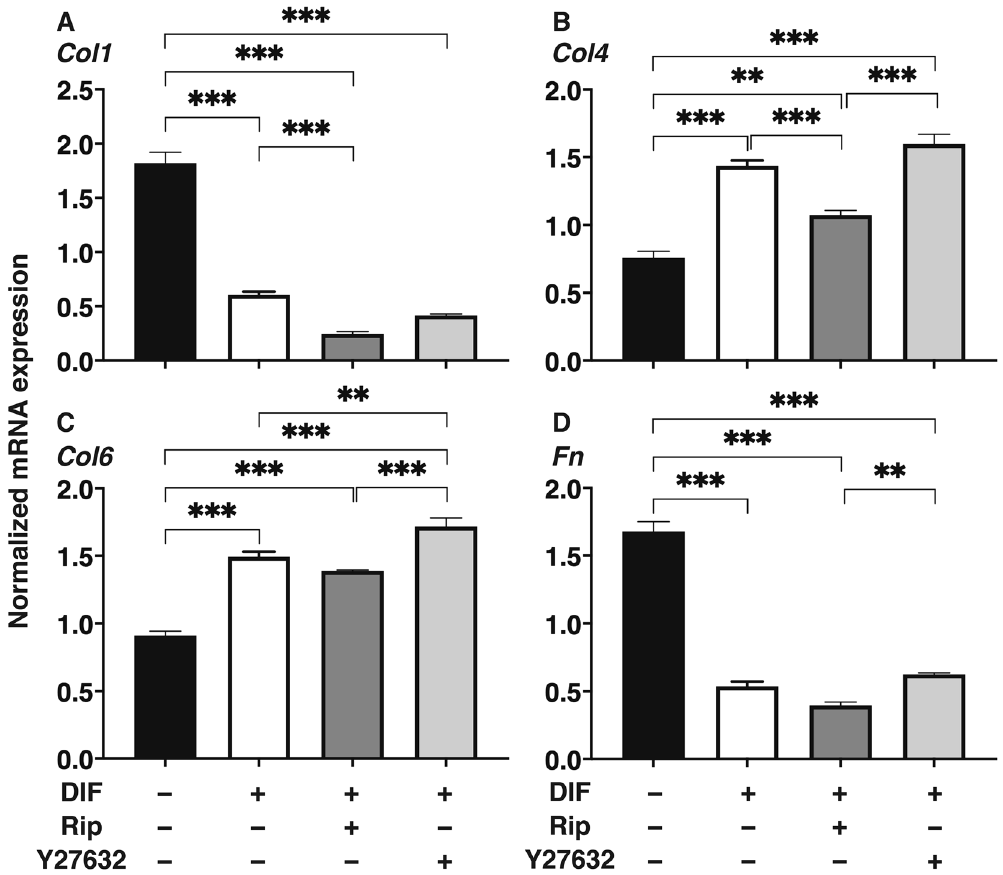
Figure 2. Effects of ROCK-i on ECM expression of 2D cultured 3T3-L1 cells. The 2D cultured 3T3-L1 preadipocytes (DIF−) and their adipogenic differentiation (DIF+) without or with 10 µM Ripasudil (Rip) or Y27632 were subjected to qPCR analysis to estimate mRNA expression of ECMs ( Col1 : collagen 1, Col4 : collagen 4, Col6 : collagen 6, Fn : fibronectin). All experiments were performed in triplicate using fresh preparations, each consisted of 5 samples. Data are presented as the arithmetic means ± standard error of the mean (SEM). ** P < 0.01, *** P < 0.005, and other pairs were not statistically significant (ANOVA followed by a Tukey’s multiple comparison